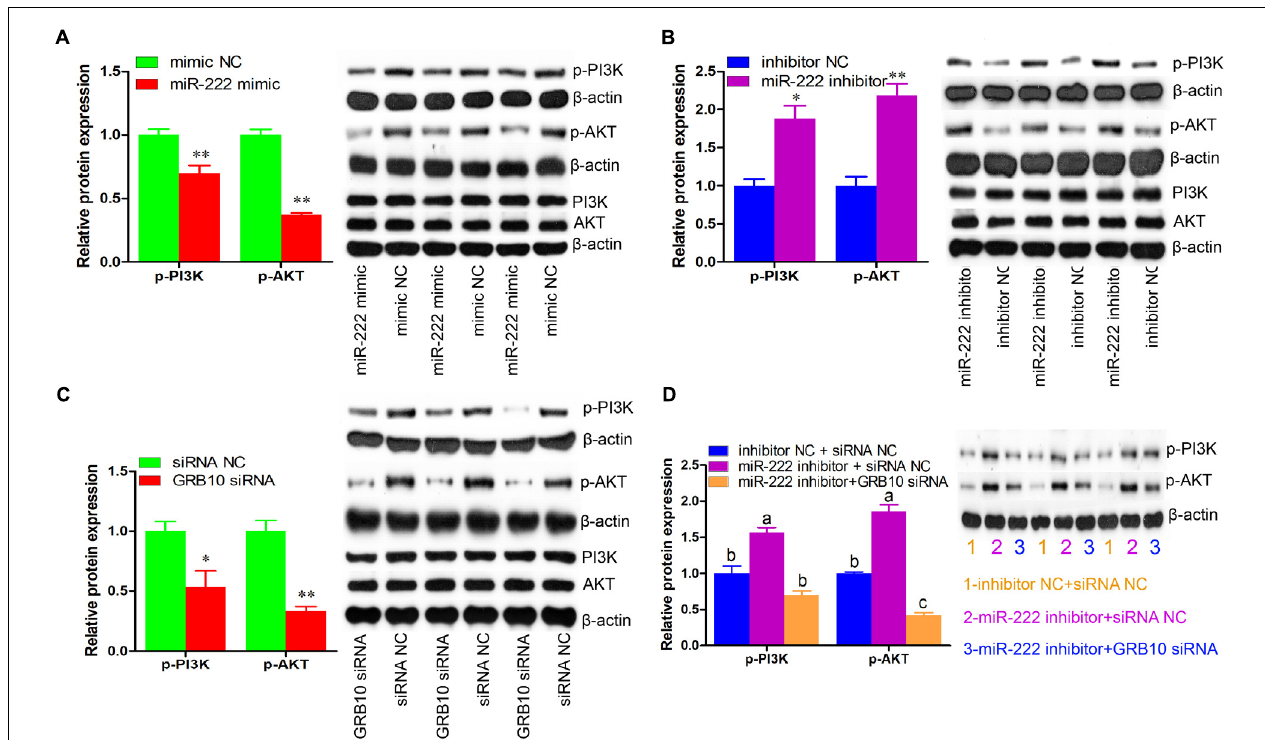
FIGURE 6 | miR-222 inactivates PI3K/AKT signaling pathway through the downregulation of GRB10 expression. The p-PI3K (phospho Tyr458), p-AKT (phospho Ser473), PI3K, and AKT protein levels were detected using western blot assay ( n = 3). The β -actin gene was used as the internal control. (A–C) The effects of miR-222 mimic (A) , miR-222 inhibitor (B) , and GRB10 siRNA (C) on the p-PI3K and p-AKT protein levels. (D) The GRB10 knockdown attenuated the effects of miR-222 inhibition on the p-PI3K and p-AKT protein levels. Data are presented as mean ± SD. ∗ P < 0.05 and ∗∗ P <